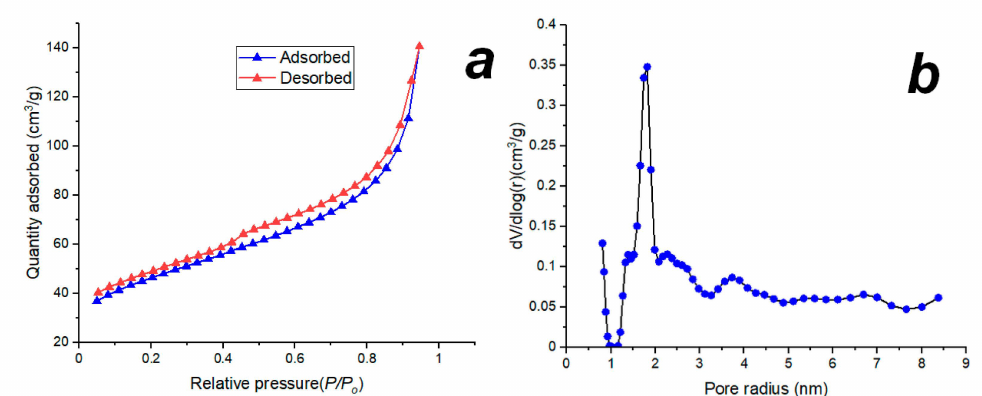
Figure 6. N 2 adsorption–desorption isotherm ( a ) and pore size distribution ( b ) for the 3D black TiO 2 /Ag/N@rGO material at 77K.